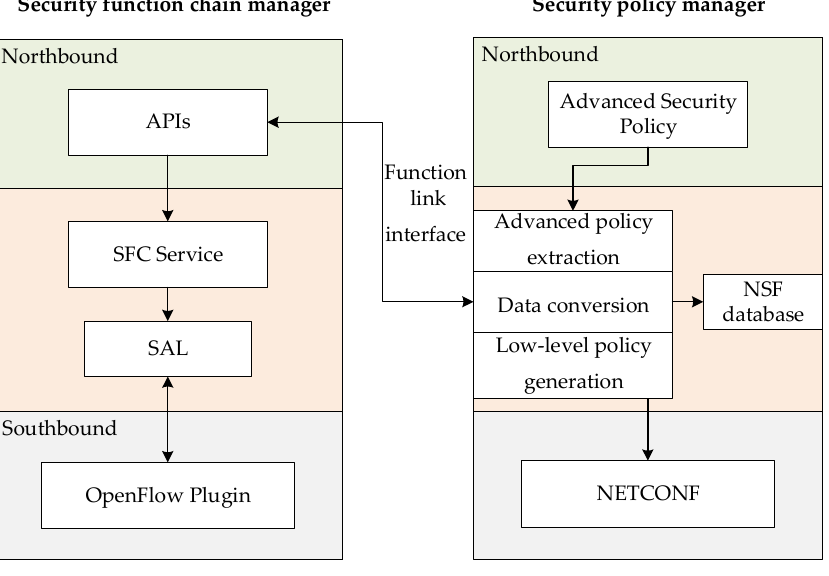
Figure 3. Orchestration Layer